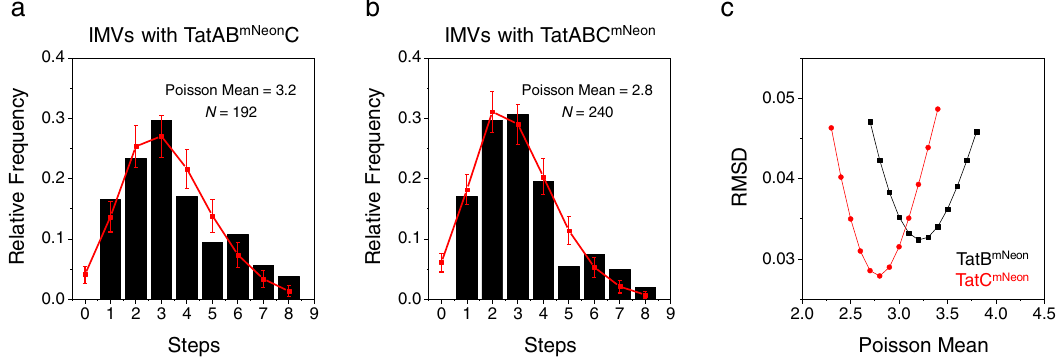
Fig. 6 Photobleaching step histograms for IMVs with TatAB mNeon C or TatABC mNeon . a , b Histograms of the number of steps observed in photobleaching pro fi les of IMVs containing TatAB mNeon C or TatABC mNeon . Tat proteins were overproduced for 1 h + ‘ 2 h chase ’ , and the number of photobleaching steps were determined with the PDD function. The data (black) were fi t assuming the simplest model, i.e., that the FDE = 1, that receptor complexes contain a single TatBC heterodimer, and that these are distributed into IMVs according to a Poisson distribution. The single-step bin contained contaminants that bleached in a single step, and occurred at a density of ~2 spots per microscope fi eld (~2.7% of total CellMask-positive spots; see text and Supplementary Fig. 4). Consequently, the data were fi t to step bins 2 – 8. The best fi t (red) was determined by the least root-mean-square deviation (RMSD) between the experimental and expected values (Poisson probabilities). Error bars are standard deviations (SDs) obtained from 5000 simulated distributions of N values each, where N is the number of experimental measurements from a single IMV preparation, as indicated. c The optimal Poisson mean. The RMSD (step bins 2 – 8) for different Poisson mean values were calculated for the data in a , b , assuming that all mNeon proteins were actively fl uorescent (FDE = 1). The minimum RMSD occurs at Poisson means of ~3.2 and ~2.8 for TatB mNeon and TatC mNeon , respectively; the corresponding predicted distributions are shown in a , b